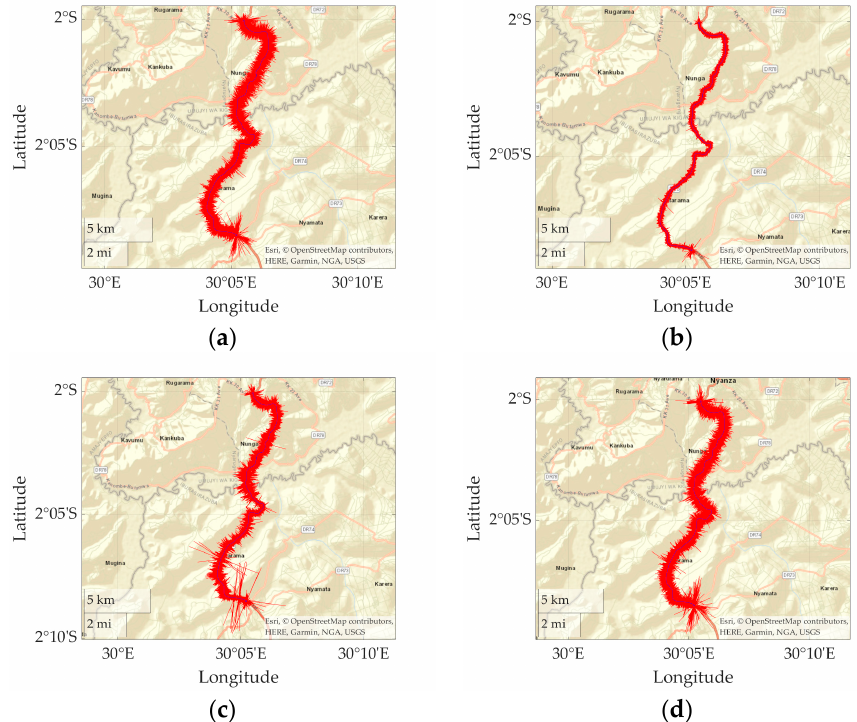
Figure 8. The bus for measurement: ( a ) the bus; ( b ) the sensor fixed to the floor inside the vehicle; ( c ) the bus in motion.